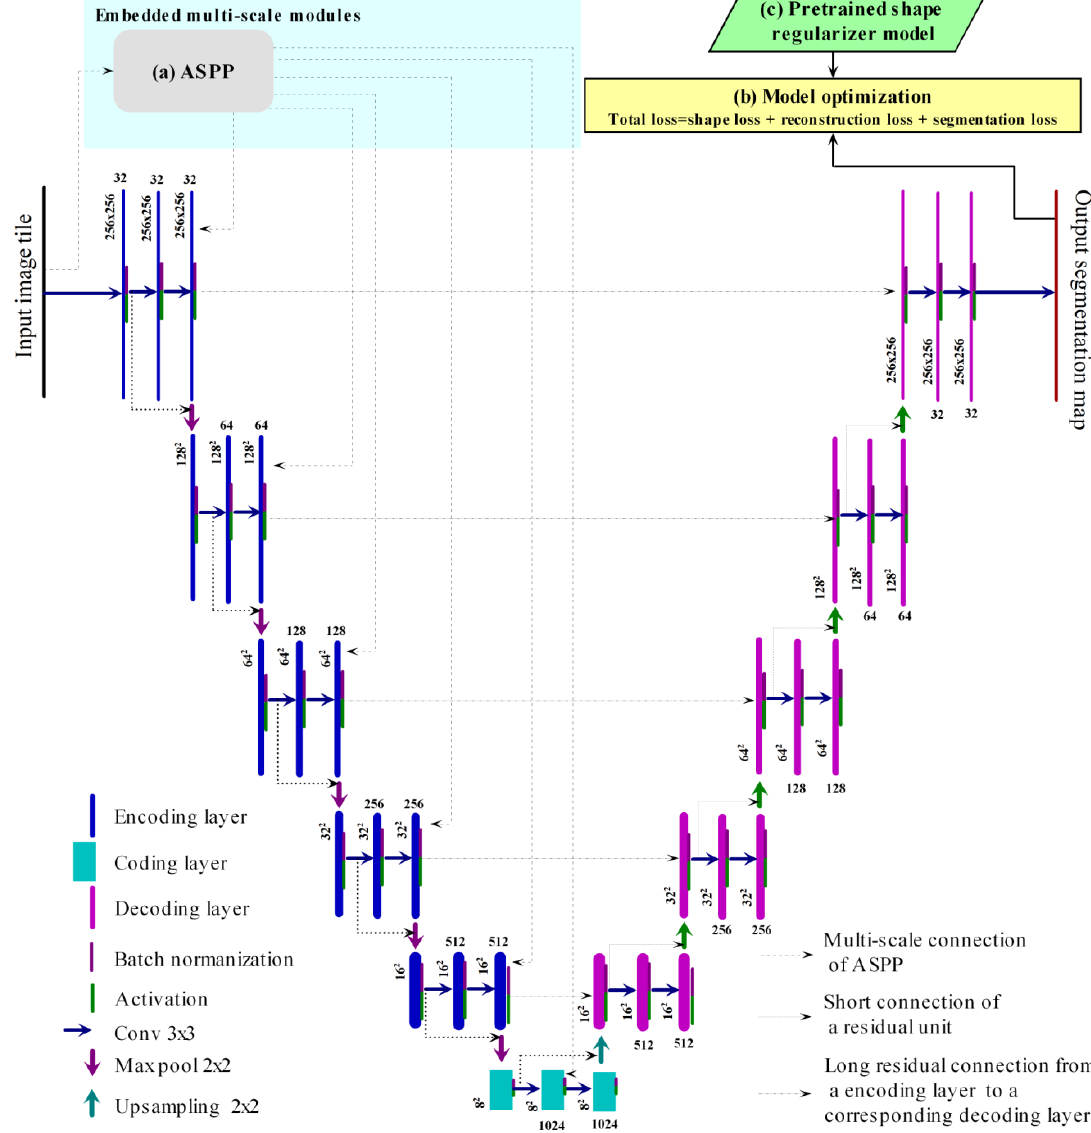
Figure 1. The architecture based on the encoder-decoder U-Net structure with fusion of residual connections, multi-scale ASPP (atrous spatial pyramid pooling) modules and shape regularizer .